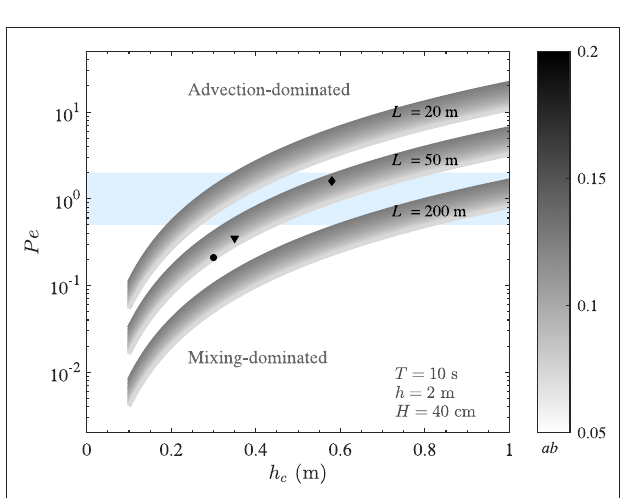
FIGURE 3 | Variation of the Péclet number with canopy height ( h c ) and dimensionless frontal area ( ab ). Variables held constant are indicated in the figure. The blue band represents Pe ∼ O (1). The Péclet number of real canopies span a wide range and a small variation in the canopy height can lead to significant changes in Pe . The black diamond, triangle, and circle markers represent estimated values of Pe of canopies shown in Figures 2A–C , respectively, highlighting that real canopies can fall within the Pe < 1, Pe > 1, or Pe ∼ O (1)